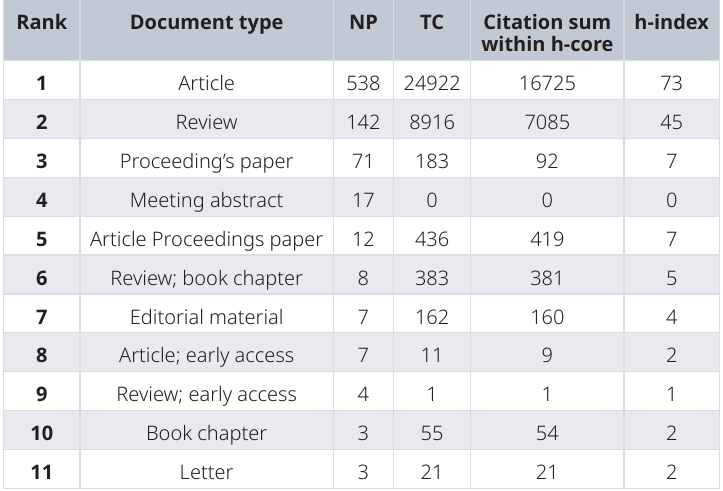
Table 2. Type of research.